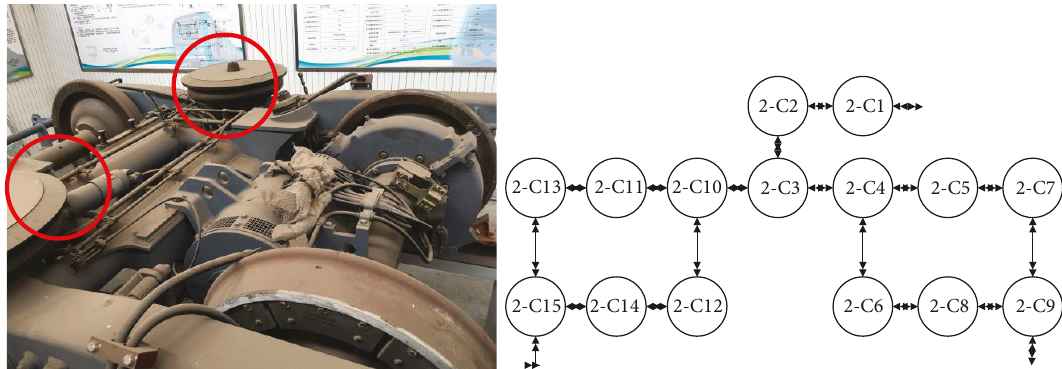
Figure 7: Model of air spring